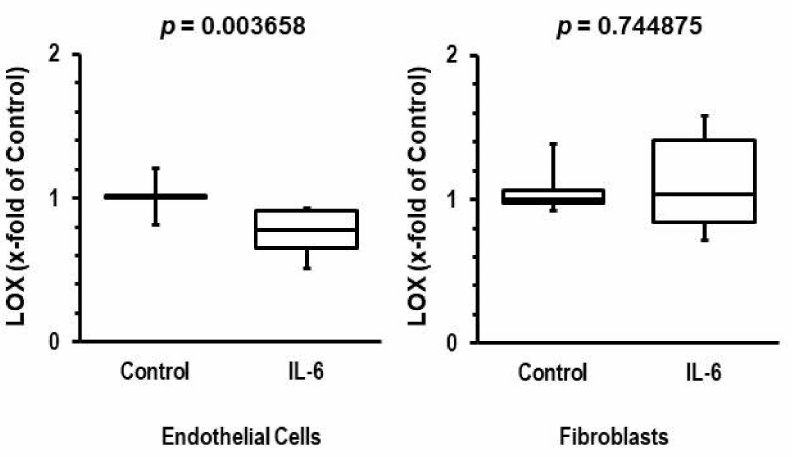
Figure 3. Effect of interleukin-6 (IL-6) on LOX mRNA expression in isolated microvascular rat endothelial cells and cardiac fibroblasts. mRNA expression of LOX was normalized to beta-2- microglobulin as a housekeeping gene. Mean expression of control cultures is set as 1. Cells were incubated for 24 h with IL-6 (10 ng/mL). The box and whiskers plots show the total range (whiskers), Q25, Q50, and Q75. Exact p -values are given (n = 6 cultures